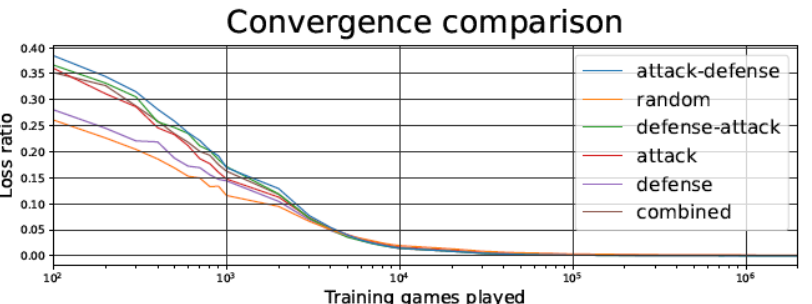
Figure 10. Connect-4 TD agent loss ratio during the training phase as a function of the number of games played, for the different training strategies.